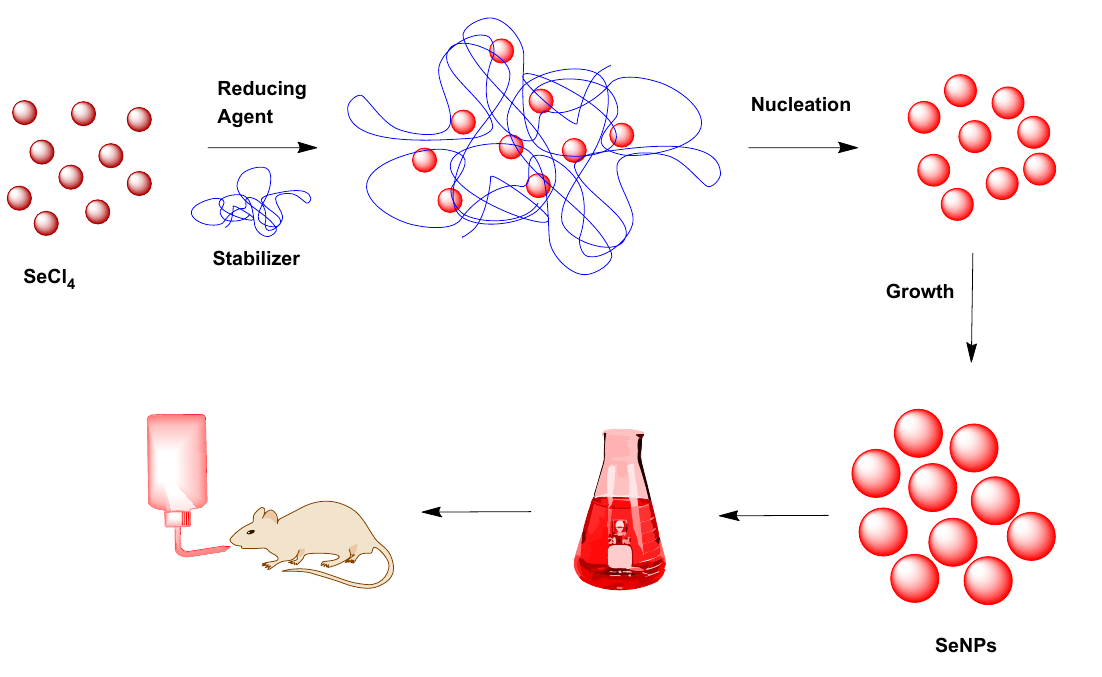
Figure 2. SeNP synthesis procedure via Se tetrachloride (SeCl 4 ), ascorbic acid (reductor) and poly(sodium 4-styrenesulfonate) (stabilizer).